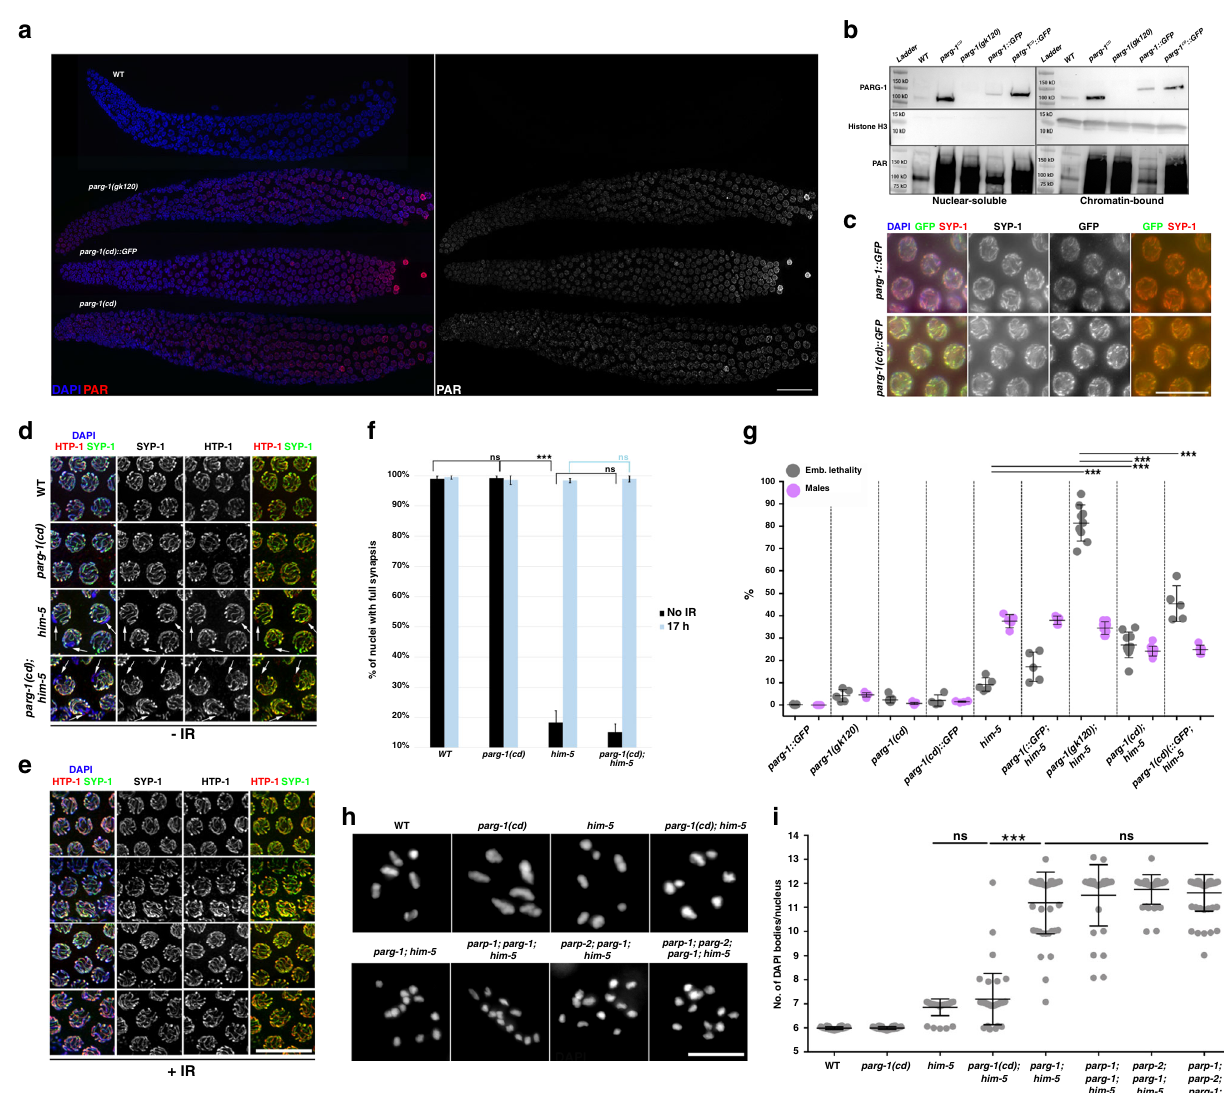
Fig. 6 PARG-1 catalytic activity is dispensable for recombination. a Left: whole-mount germlines of the indicated genotypes stained with anti-PAR antibodies and DAPI. Right: PAR staining. Scale bar 20 μ m. Analysis was performed in biological duplicates. b Western blot with fractionated extracts shows higher PARG-1 CD ::GFP and PARG-1 CD abundance compared to controls. Anti-histone H3 was used as loading control for chromatin-bound fraction. Western blot (bottom) con fi rmed accumulation of PAR in both parg-1(cd) and parg-1(gk120) null mutants. Analysis was performed in biological duplicates. c Non-deconvolved images of late pachytene nuclei showing SYP-1 and elevated levels of PARG-1 CD ::GFP versus PARG-1::GFP with delayed redistribution in late pachytene nuclei. Scale bar 10 μ m. Analysis was performed in biological duplicates. d The X-chromosome undergoes desynapsis in parg-1(cd); him-5 double mutants. Arrows indicate the unsynapsed X chromosome in the indicated genotypes before irradiation. Scale bar 10 μ m. Analysis was performed in biological duplicates. e Exposure to IR fully rescues X-chromosome desynapsis in parg-1(cd); him-5 double mutants. Scale bar 10 μ m. Analysis was performed in biological duplicates. f Quanti fi cation of synapsis by SYP-1 and HTP-3 co-staining in the indicated genotypes before and after IR exposure. Error bars indicated S.E.M. Statistical signi fi cance was assessed by χ 2 test (signi fi cance level for p < 0.05, *** p < 0.0001, ns = not signi fi cant). Number of nuclei analysed (0 Gy-10 Gy): WT (215 – 205), parg-1(cd) (137 – 146), him-5 (169 – 190), parg-1(cd); him-5 (165 – 212). g Blocking PARG-1 catalytic activity caused milder synergistic effects when combined with him-5 mutants in contrast to parg-1(gk120); him-5 . Center of error bars indicates mean. Error bars indicate standard deviation and asterisks show statistical signi fi cance calculated by two-tailed nonparametric Mann – Whitney test. (*** p < 0.0001 ) . Number of animals scored: parg-1::GFP (5), parg-1(gk120) (5), parg-1(cd)::GFP (4), him-5 (5), parg-1::GFP; him-5 (5), parg-1(gk120); him-5 (9), parg-1(cd); him- 5 (10), parg-1(cd)::GFP; him-5 (10). h DAPI-staining and quanti fi cation of DAPI-bodies ( i ) in diakinesis nuclei for the indicated genotypes. Center of error bars indicates mean. Error bars indicate standard deviation and asterisks show statistical signi fi cance calculated by two-tailed nonparametric Mann – Whitney test. (*** p < 0.0001 ) . Scale bar 5 μ m. Number of nuclei analysed is reported in Supplementary Table 2. have compromised glycohydrolase activity. PARG-1 CD ::GFP was To assess whether the catalytic activity of PARG-1 was required expressed and loaded in meiocytes (Fig. 6c) but displayed pro- for the induction and/or repair of meiotic DSBs, we analysed the longed localization along the chromosomes in late pachytene parg-1(cd); him-5 double mutants as described above. cells, were PARG-1 normally is retained mostly at the short arm X-chromosome desynapsis (Fig. 6d – f) was suppressed upon IR of the bivalent in control animals (Fig. 2). exposure in both parg-1(cd); him-5 and him-5 mutants, in NATURE COMMUNICATIONS| (2020) 11:4869